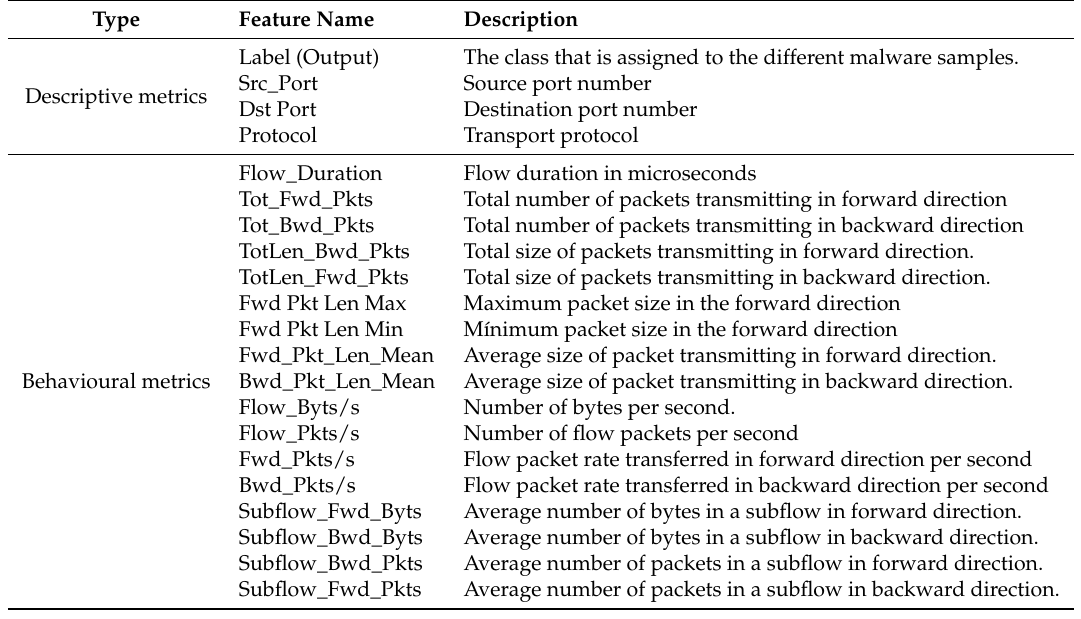
Table 1. Classification features used in CIC-AWS-2018 dataset and ISOT HTTP Botnet